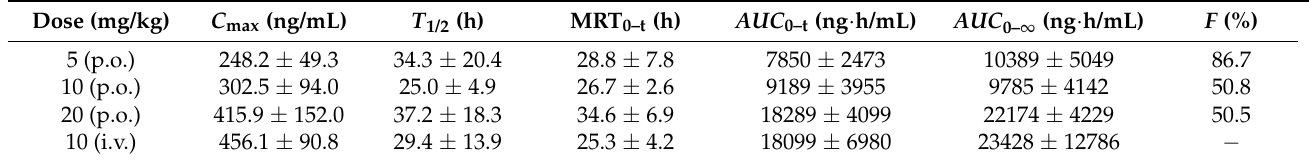
Table 4. Pharmacokinetic parameters of Hu7691 in dogs.